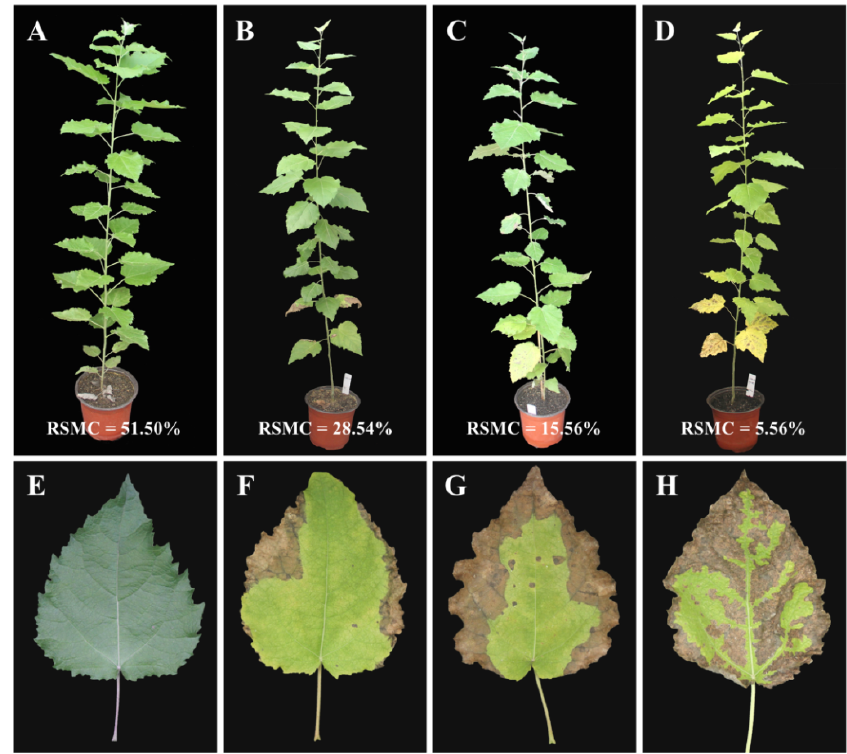
Figure 2. Morphological changes of basal leaves in poplar 717 under different relative soil moisture contents (RSMC). ( A ) D0 plant, ( B ) D5 plant, ( C ) D10 plant, ( D ) D15 plant, ( E ) D0 basal leaf, ( F ) D5 basal leaf, ( G ) D10 basal leaf, ( H ) D15 basal leaf.